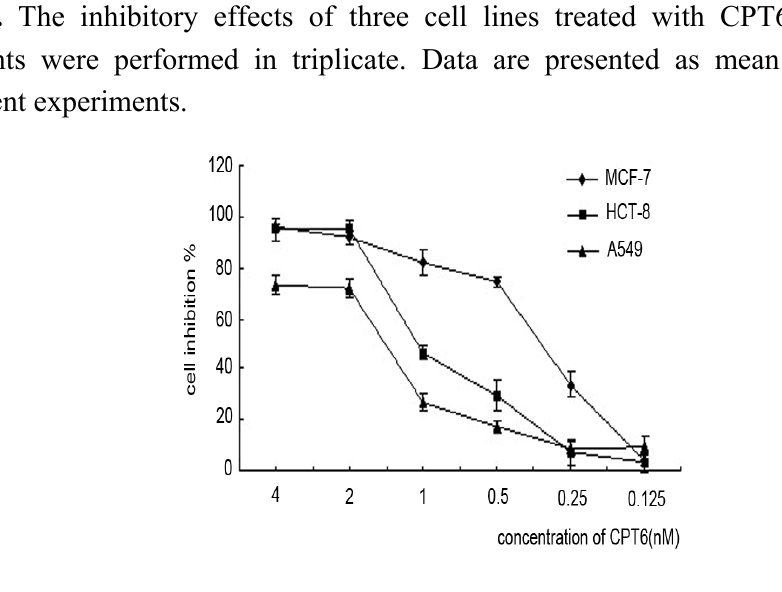
Table 1. Cells were incubated with CPT6 (from 0.125 to 4 nM) for 24 h, 48 h and 72 h (* p < 0.05, ** p <